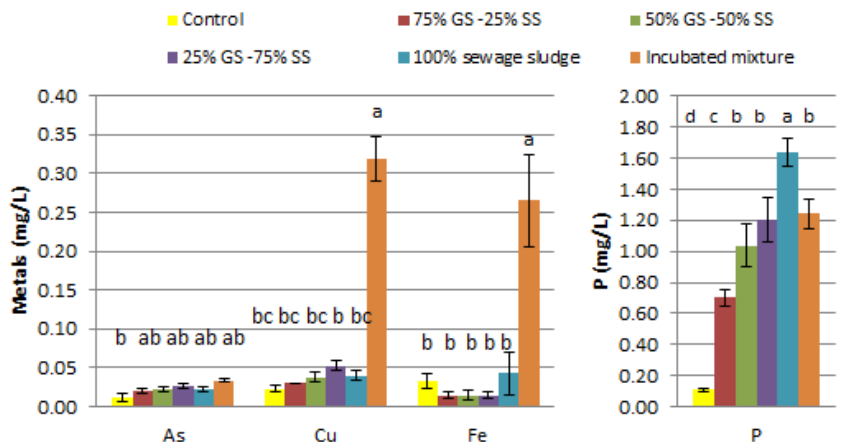
Figure 3. Concentrations (mg / L) of metals (As, Cu, Fe) and P in leachates from soils treated with pyrolyzed materials (averaged value ± standard error; n = 3 or 4). Values for Cd are not shown because its concentration was always below the detection limit. Letters are comparing the treatments. Comparing the pyrolyzed materials, the mixture with 50% grape seeds - 50% sewage sludge exhibited intermediate